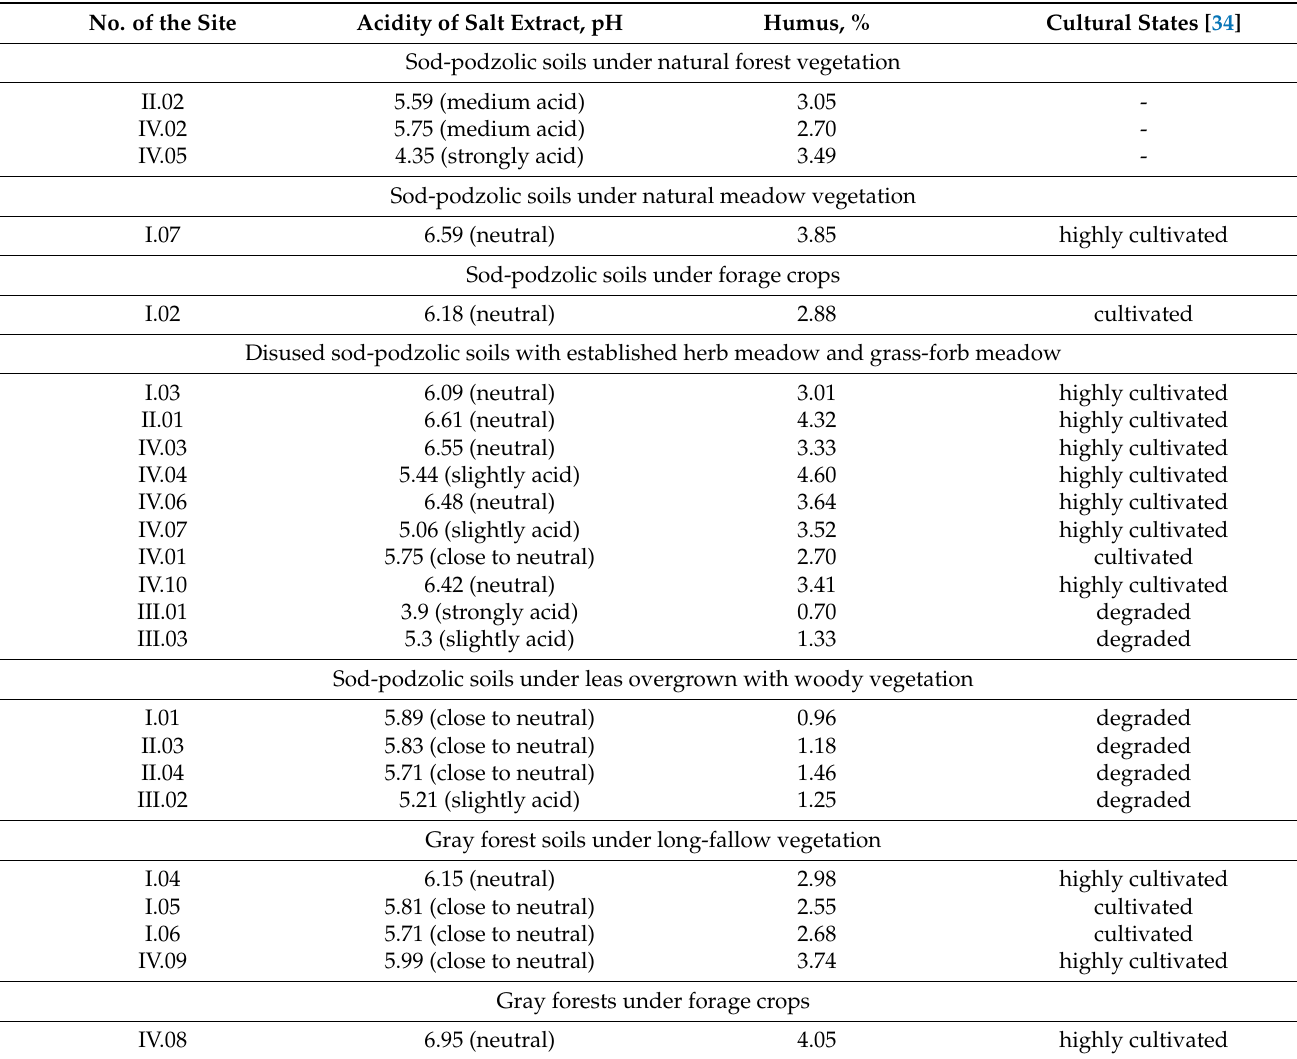
Table 2. Condition of the soil cover of the control